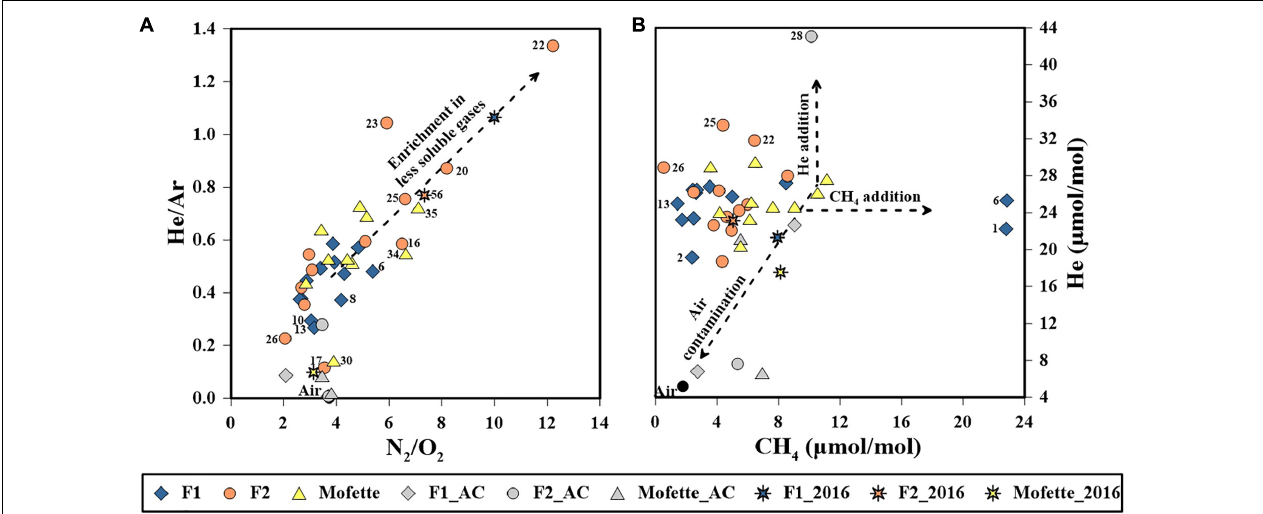
FIGURE 3 | Binary plots of (A) He/Ar vs. N 2 /O 2 and (B) He vs. CH 4 . Secondary processes are indicated with dashed arrows. The abbreviation _AC stands for air contamination, while data of samples collected during 2016 are from Bräuer et al.